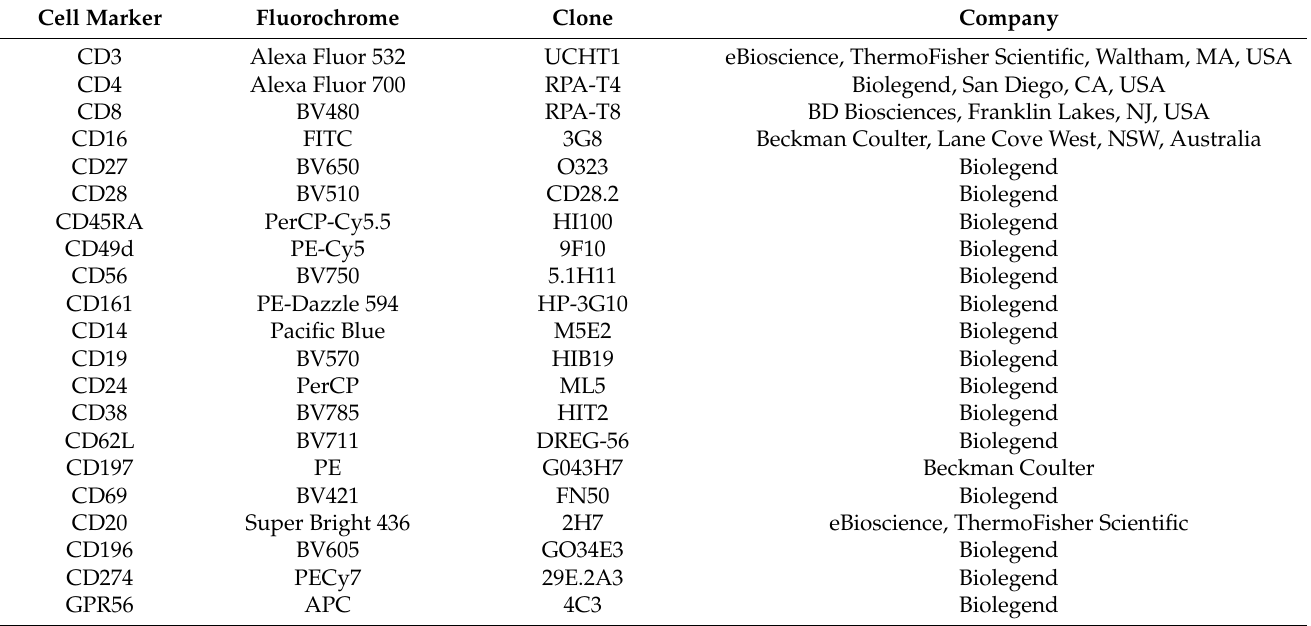
Table 2. List of fluorescently conjugated antibodies and clones used for flow cytometric analysis. Cell